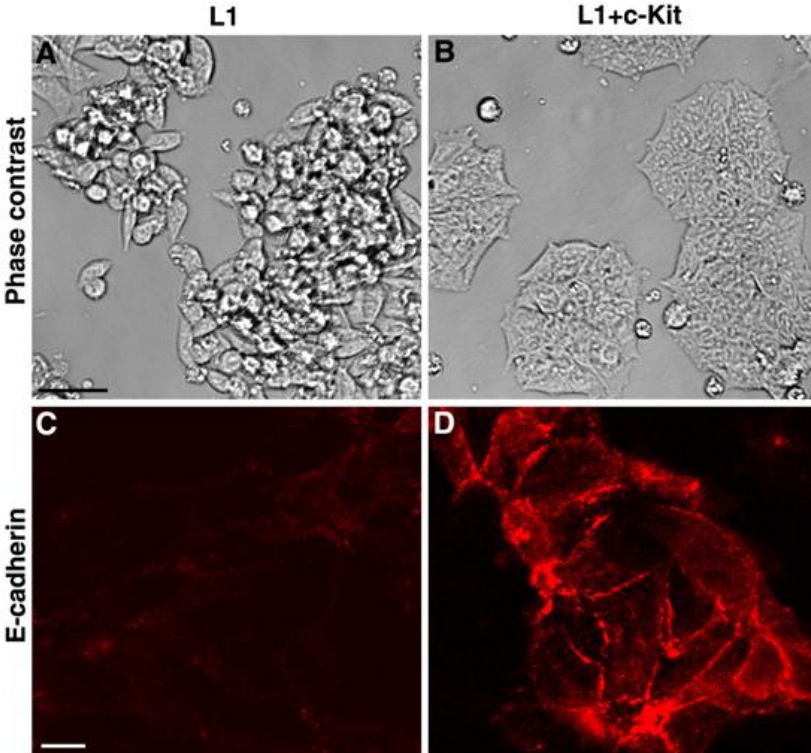
Figure 3. The expression of c-Kit in CRC cells induces a mesenchymal to epithelial conversion. ( A ) L1 expressing Ls174T CRC cells are organized in small three-dimensional aggregates; ( B ) The transfection of c-Kit into such cells results in cell spreading and a more epithelial-like organization of cells; ( C ) The L1 transfected CRC cells do not express significant levels of E-cadherin; ( D ) Transfection of c-Kit induces E-cadherin expression and organization at cell-cell contacts (modified from reference [42]). The bar represents 20 m.